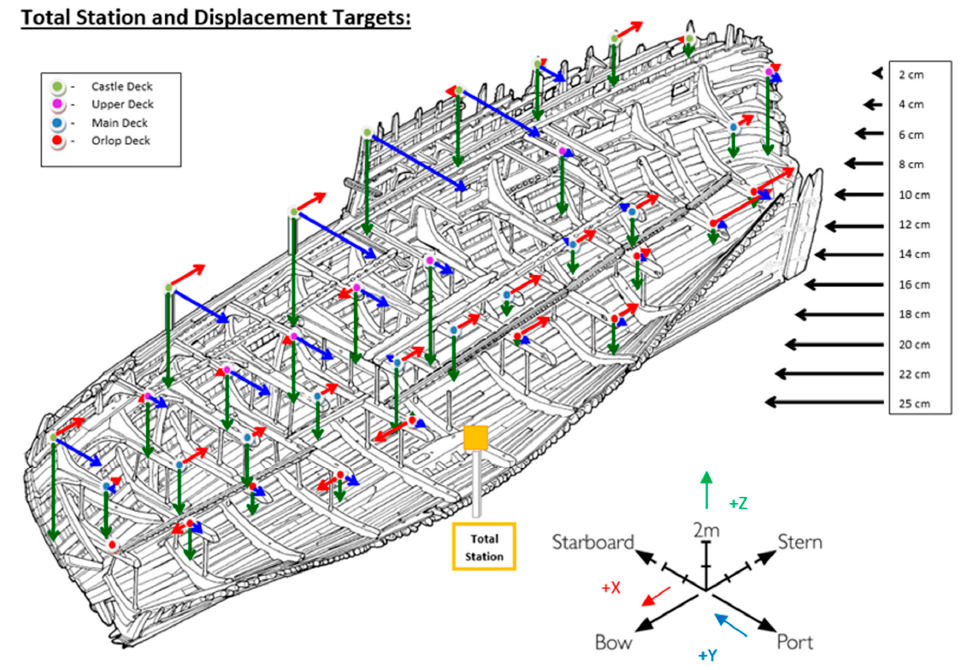
Figure 2. Shows the total displacement of the targets between 2013 and 2020 in the X (red arrows), Y (blue arrows) and Z (green arrows) directions. The scale bar on the right is a reference for the magnitude of the displacements.